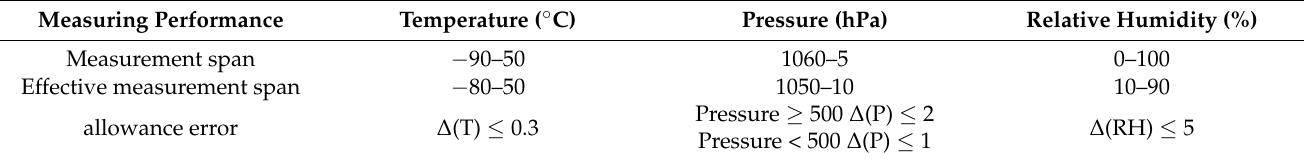
Table 1. Performance parameters of the GTS11 radiosonde.